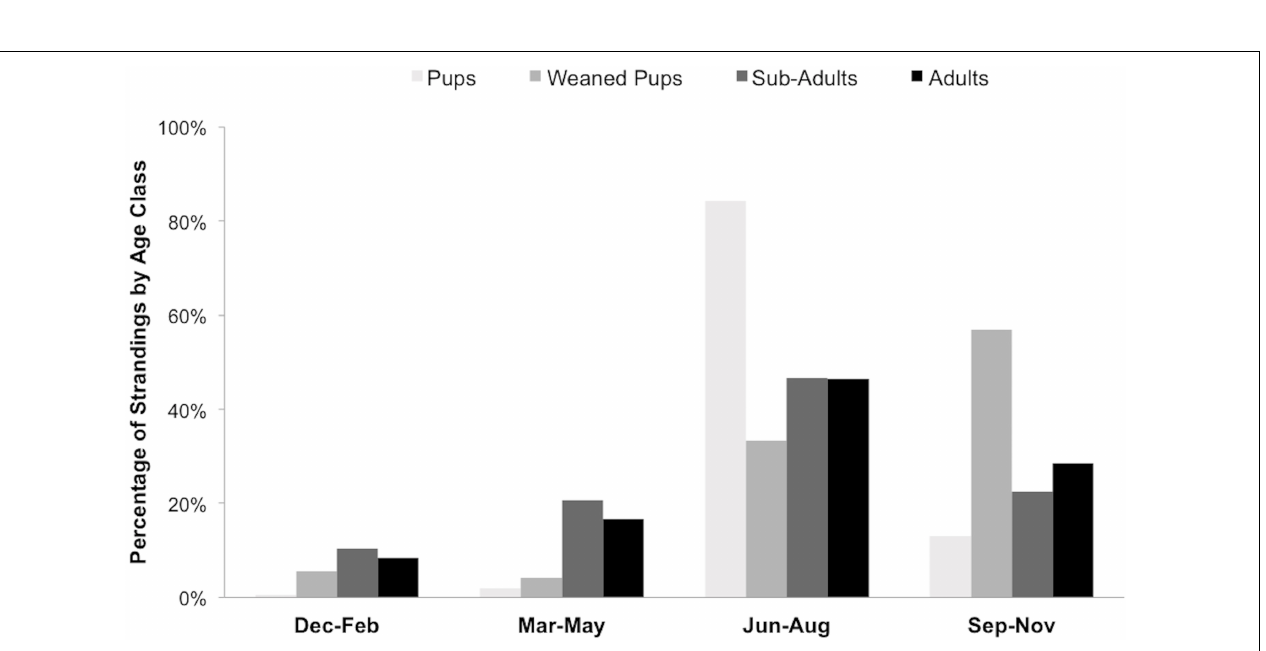
FIGURE 4 | Percentage of stranded harbor seals ( n = 882) in San Juan County per age class by season between 2002 and 2018.